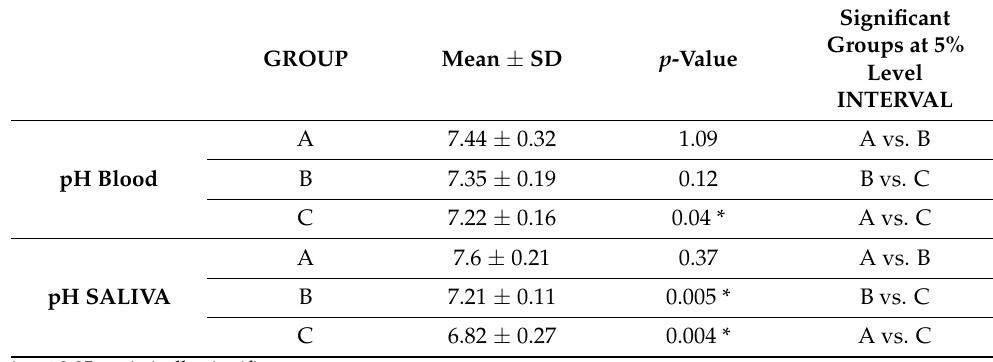
Table 3. Comparison of mean values of the variables (before treatment) between different study groups.